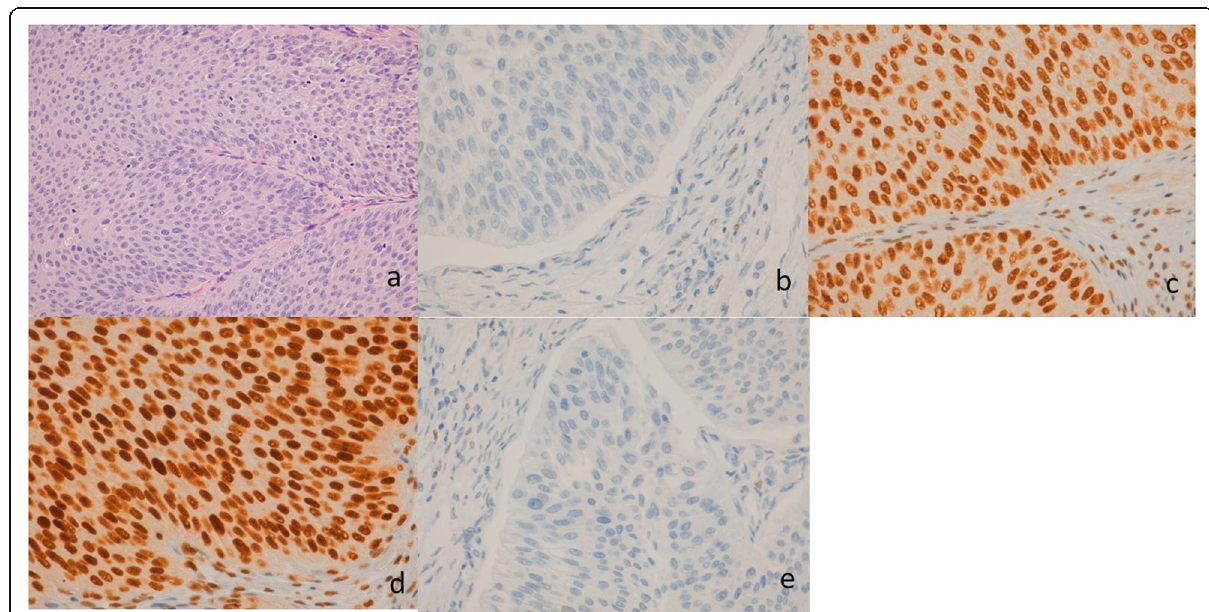
Fig. 1 Photomicrographs to illustrate the inmunohistochemistry for mismatch repair protein. Hematoxylin & eosin stain of the tumor (a). Absent nuclear staning of MLH1 (b). Intact nuclear expression of PMS2 (c). Absent nuclear staning of MSH2 (d). Intact nuclear expression of MSH6 (e). Magnification: (a) 20x; (b-e)